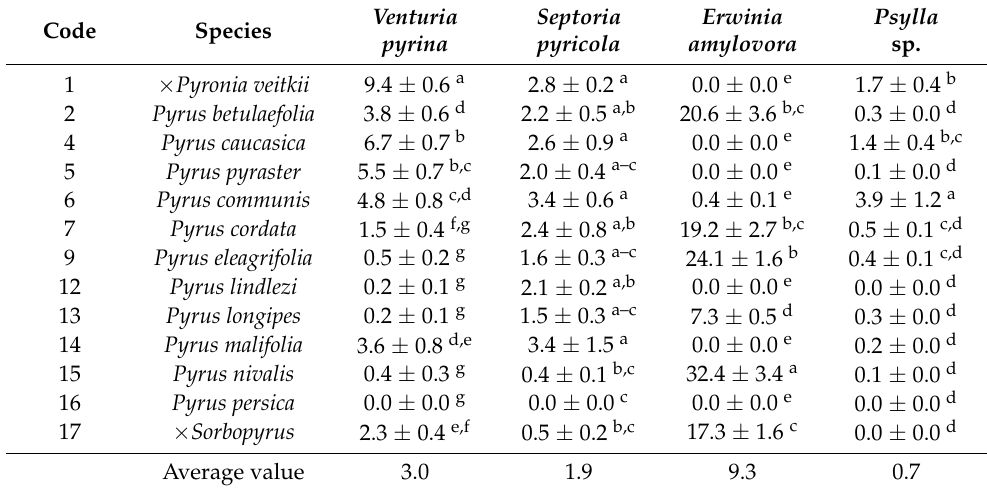
Table 1. Responses to the principal diseases and pests of 13 pear species (as degree of attack, DA %) 1 .